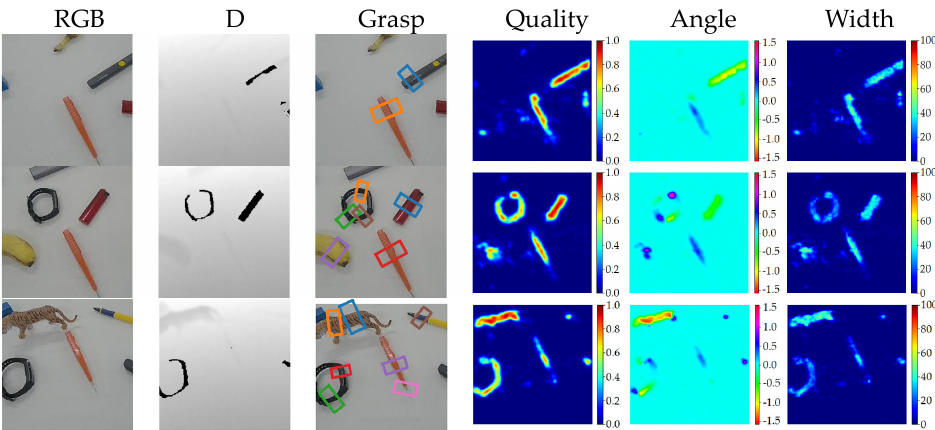
Figure 6. The test result of HTC-Grasp in the real-world multiple objects environment. The first and second columns depict RGB and depth images, respectively. The third column displays the grasping rectangles and successful grasps are marked as rectangles. The final three columns depict heatmaps indicating the quality, angle, and width of the detected grasps. The quality heatmaps characterizes the degree of confidence that each pixel is a valid grasping location.